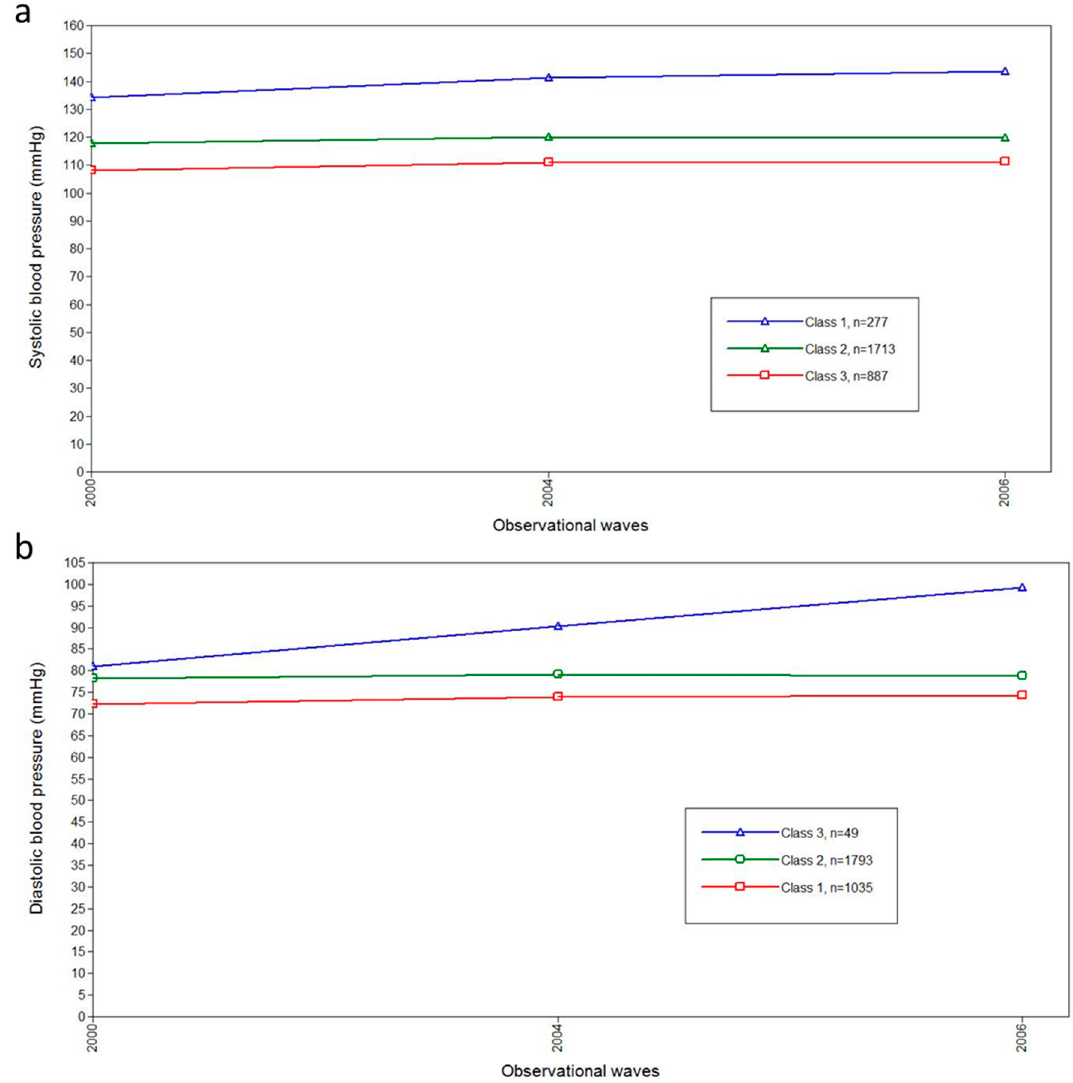
Figure 2. The blood pressure trajectories in the three-class model by GMM for stroke. ( a ) The plots for classifications of systolic blood pressure trajectories by GMM for stroke. ( b ) The plots for classifications of diastolic blood pressure trajectories by GMM for stroke. Abbreviations: mmHg, millimeter of mercury; GMM, growth mixture model.